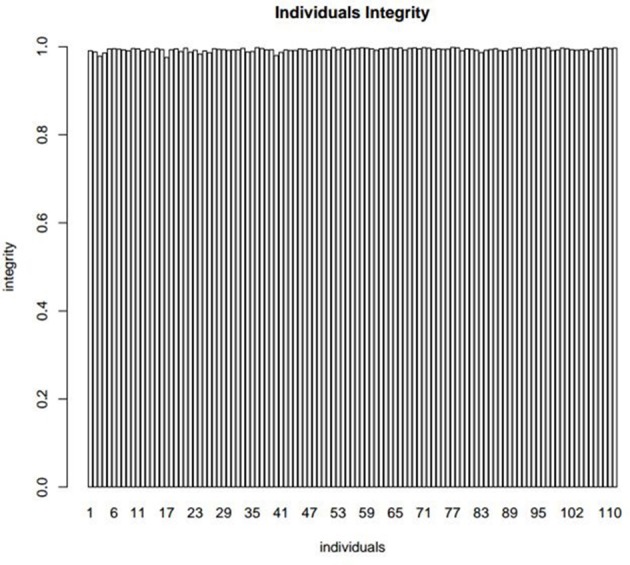
The integrity distribution map of all individuals. The x-axis represents the 112 individuals and y-axis represents the complete degree of mapped markers.